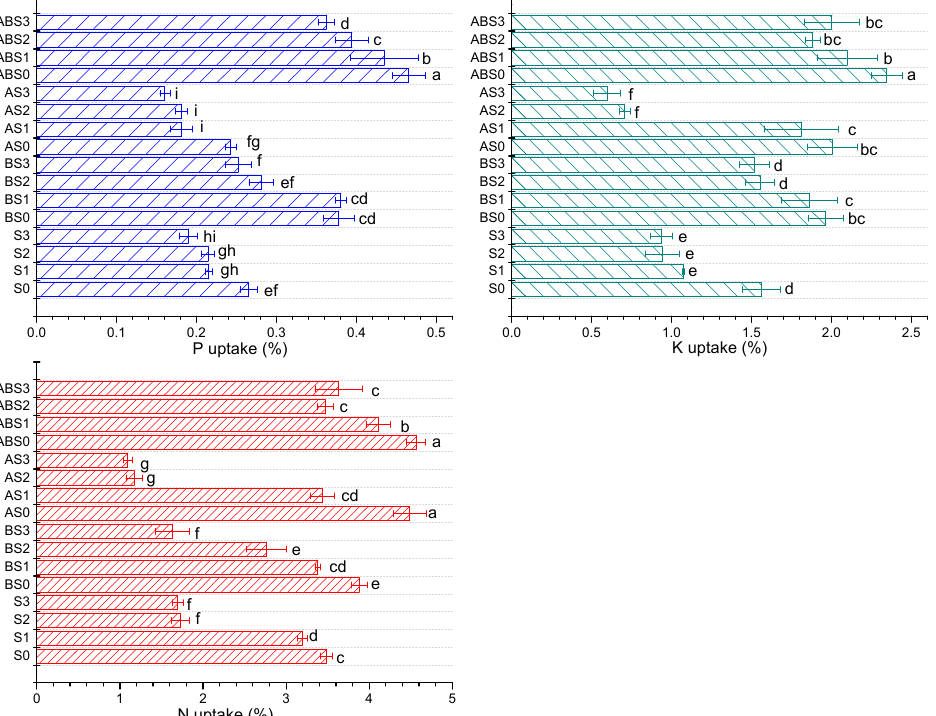
Figure 4 . Effect of biochar and/or AMF on percentage of N, P, and K uptake by the maize plant under salinity stress. Data present the mean ± standard deviation of three replicates and mean values followed by different letters are significantly different at p < 0.05 according to Duncan multiple range test. The significance of acronyms is the same as in Figure 1.